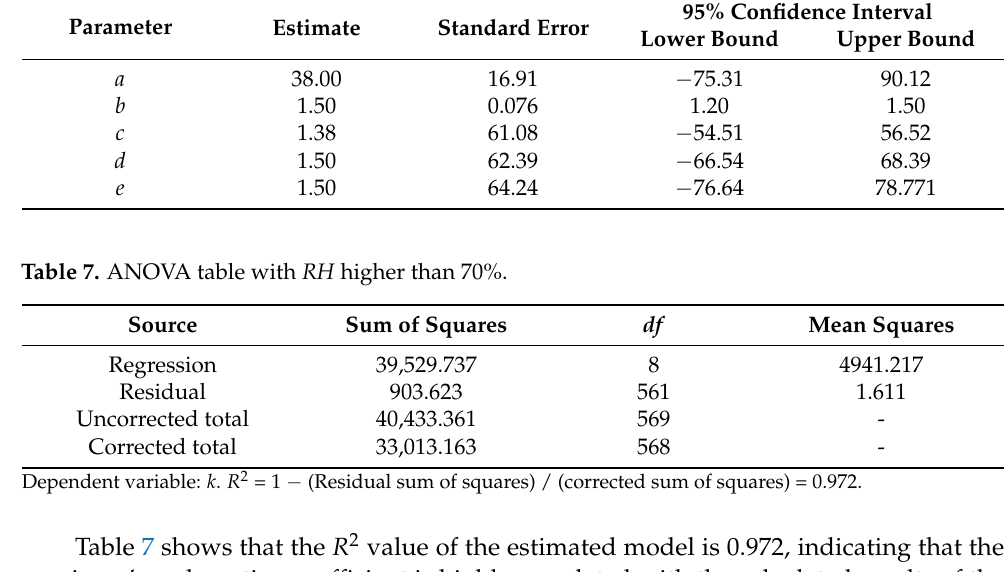
Table 6. Parameter estimates with RH higher than 70%. Parameter Estimate